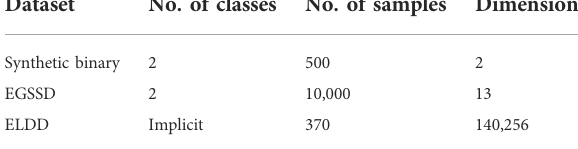
TABLE 2 Detailed information of the synthetic binary, EGSSD, and ELDD datasets. Dataset Synthetic